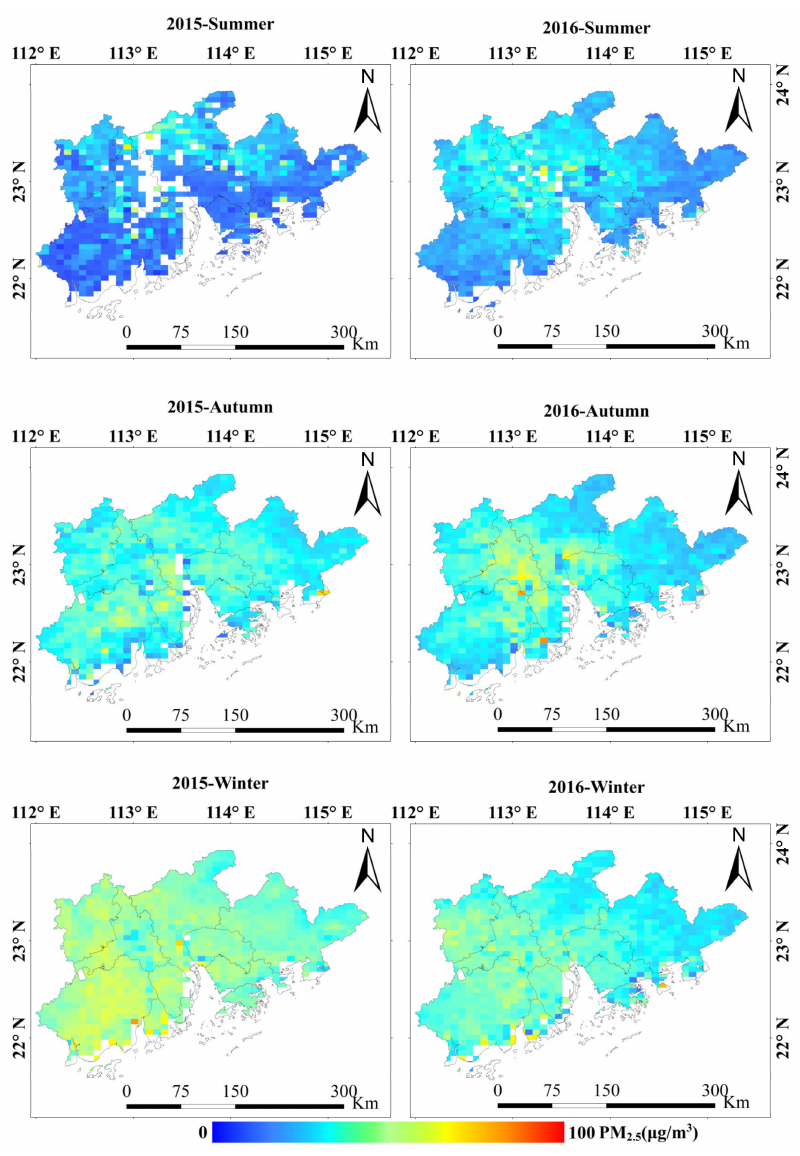
Figure 10. Spatiotemporal distributions of PM 2.5 concentrations in the Pearl River Delta